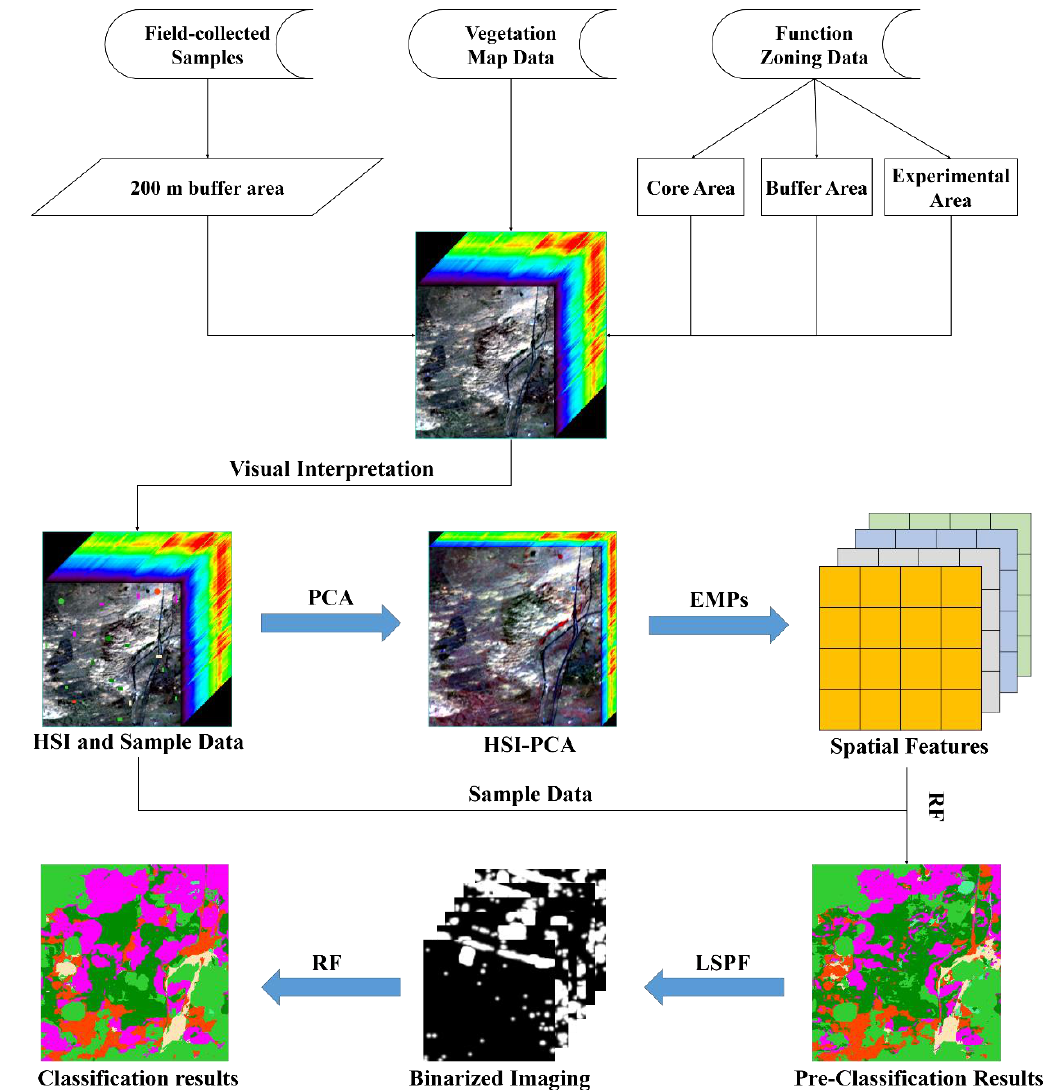
Figure 3. The flowchart of our